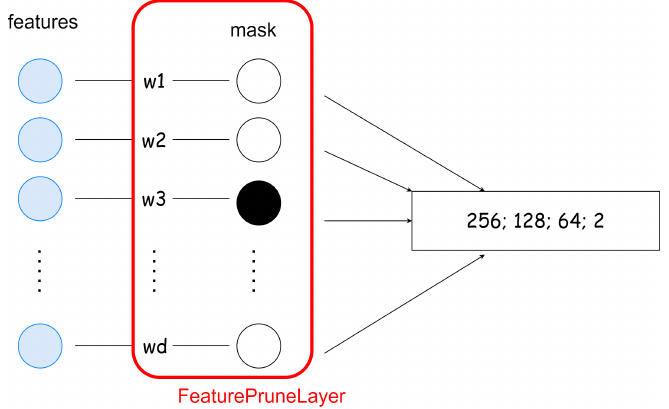
Figure 10. Architecture of the network used for